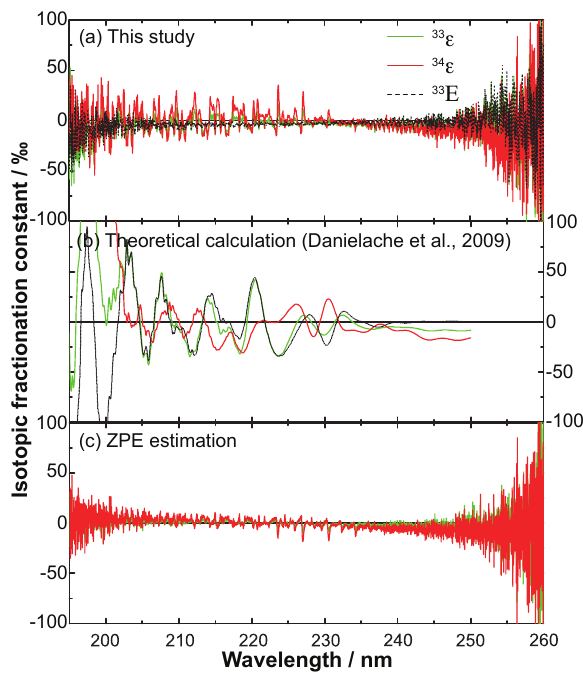
Fig. 4. Isotopic fractionation constants for sulfur species ( 33 / 34 ε ( λ )) and for 33 S excess ( 33 E ( λ )) plotted as a function of wavelength; this study (a) , theoretical calculation (Danielache et al., 2009) (b) , ZPE estimation (Miller and Yung, 2000; Danielache et al., 2009) (c) .